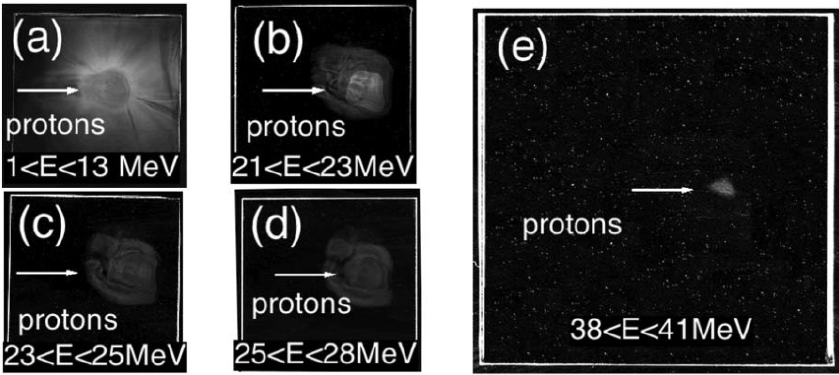
Figure 12. Proton beam footprints on the CR39 plates for a 2 μ m thick Stainless (SUS) target irradiated at the intensity of 1 × 10 21 W/cm 2 . The proton energy range detected with each layer is also